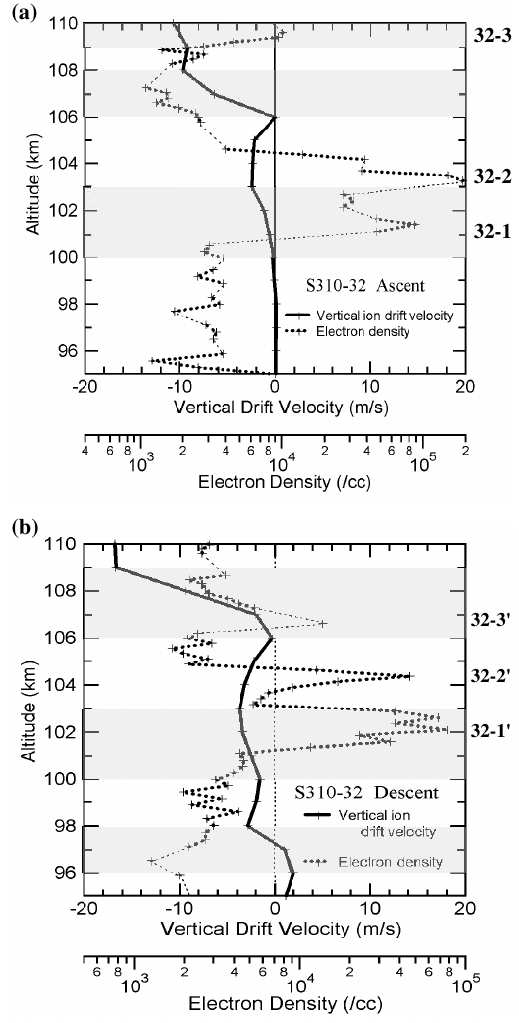
Fig. 2. The comparison between vertical ion drift velocities derived from neutral wind profiles and electron density profiles. The gray shadings represent the ion convergent regions due to the wind shear. The 32-2 and 32-2 0 peaks do not correspond to the ion accumulation regions in ( a ) and ( b ) ,